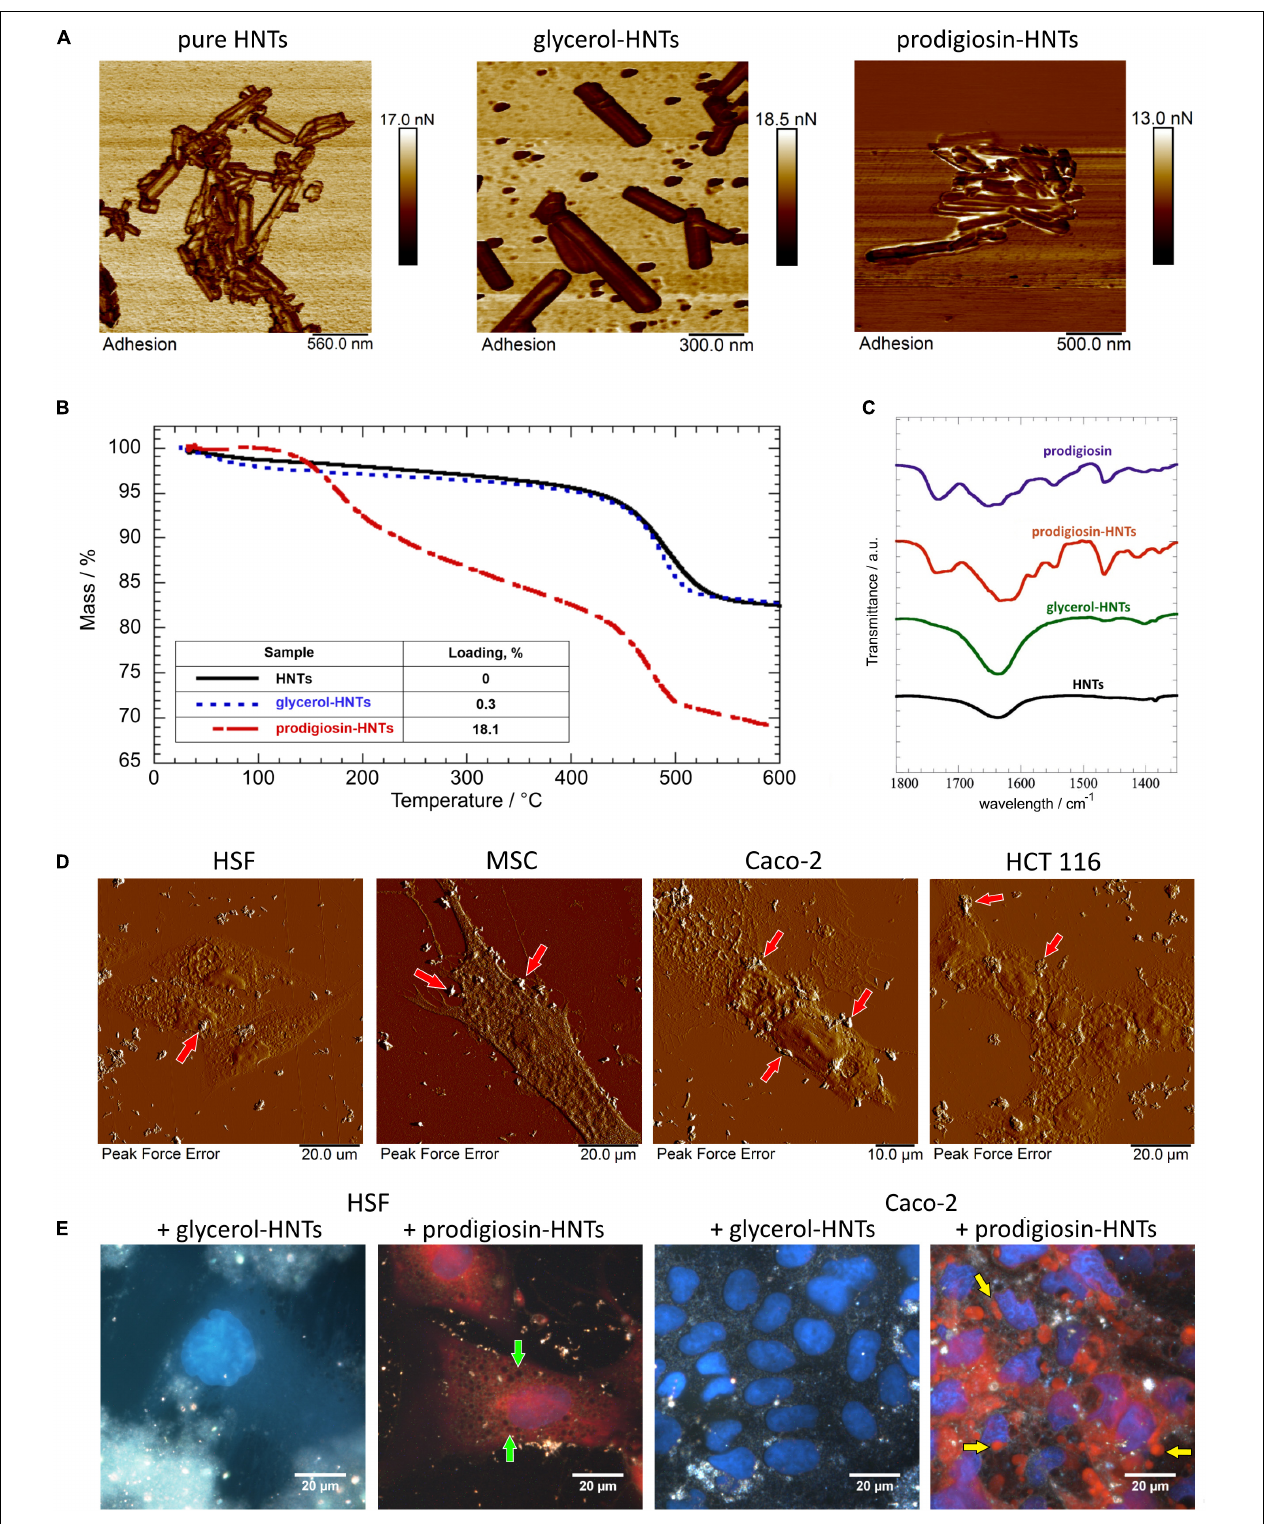
FIGURE 1 | Characterization of prodigiosin-HNTs. Atomic force microscopy images (A) of pure HNTs and loaded with glycerol and prodigiosin, demonstrating the change of nanotubes surfaces adhesiveness. TGA analysis (B) of prodigiosin-loaded HNTs demonstrated that this complex contains 18% of prodigiosin. FT-IR spectra (C) in the wavelength range between 1350 and 1800 cm − 1 . AFM images of the cells (D) indicate that hydrophobic prodigiosin-HNTs strongly attach to the cell membrane, forming large clusters. (E) prodigiosin exhibits autofluorescence, therefore its leakage from the nanotubes and the presence in the cytoplasm can be visualized using fluorescence module of hyperspectral microscope CytoViva R (cid:13) . More details see in Supplementary Figure S4 .